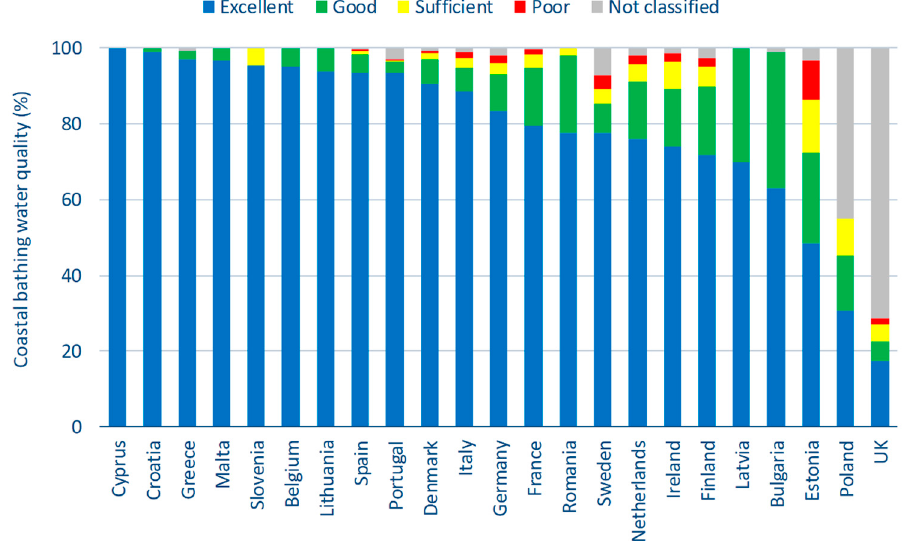
Figure 11. The quality of coastal bathing waters in EU Member States during 2020.